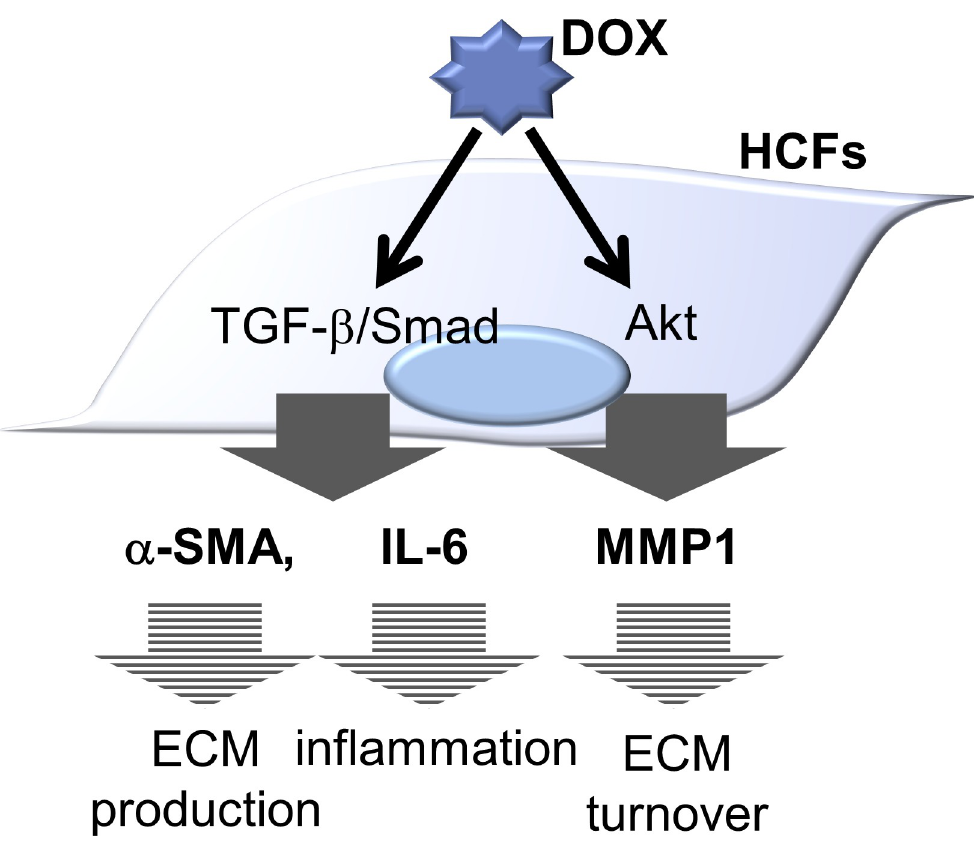
Fig 6. A proposed schematic diagram of DOX-induced pro-fibrotic changes in HCFs. DOX activated Smad and Akt signaling and increased IL-6, α -SMA and MMP1 expression in HCFs.